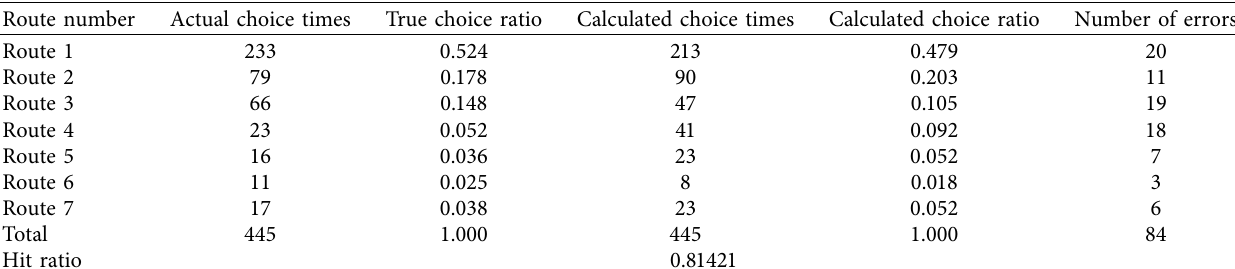
Figure 9: Routes of different passenger-carrying route categories for verification: (a) short-distance passenger-carrying routes, (b) medium- distance passenger-carrying routes, and (c) long-distance passenger-carrying routes. Table 7: Short-distance passenger-carrying route choice model verification